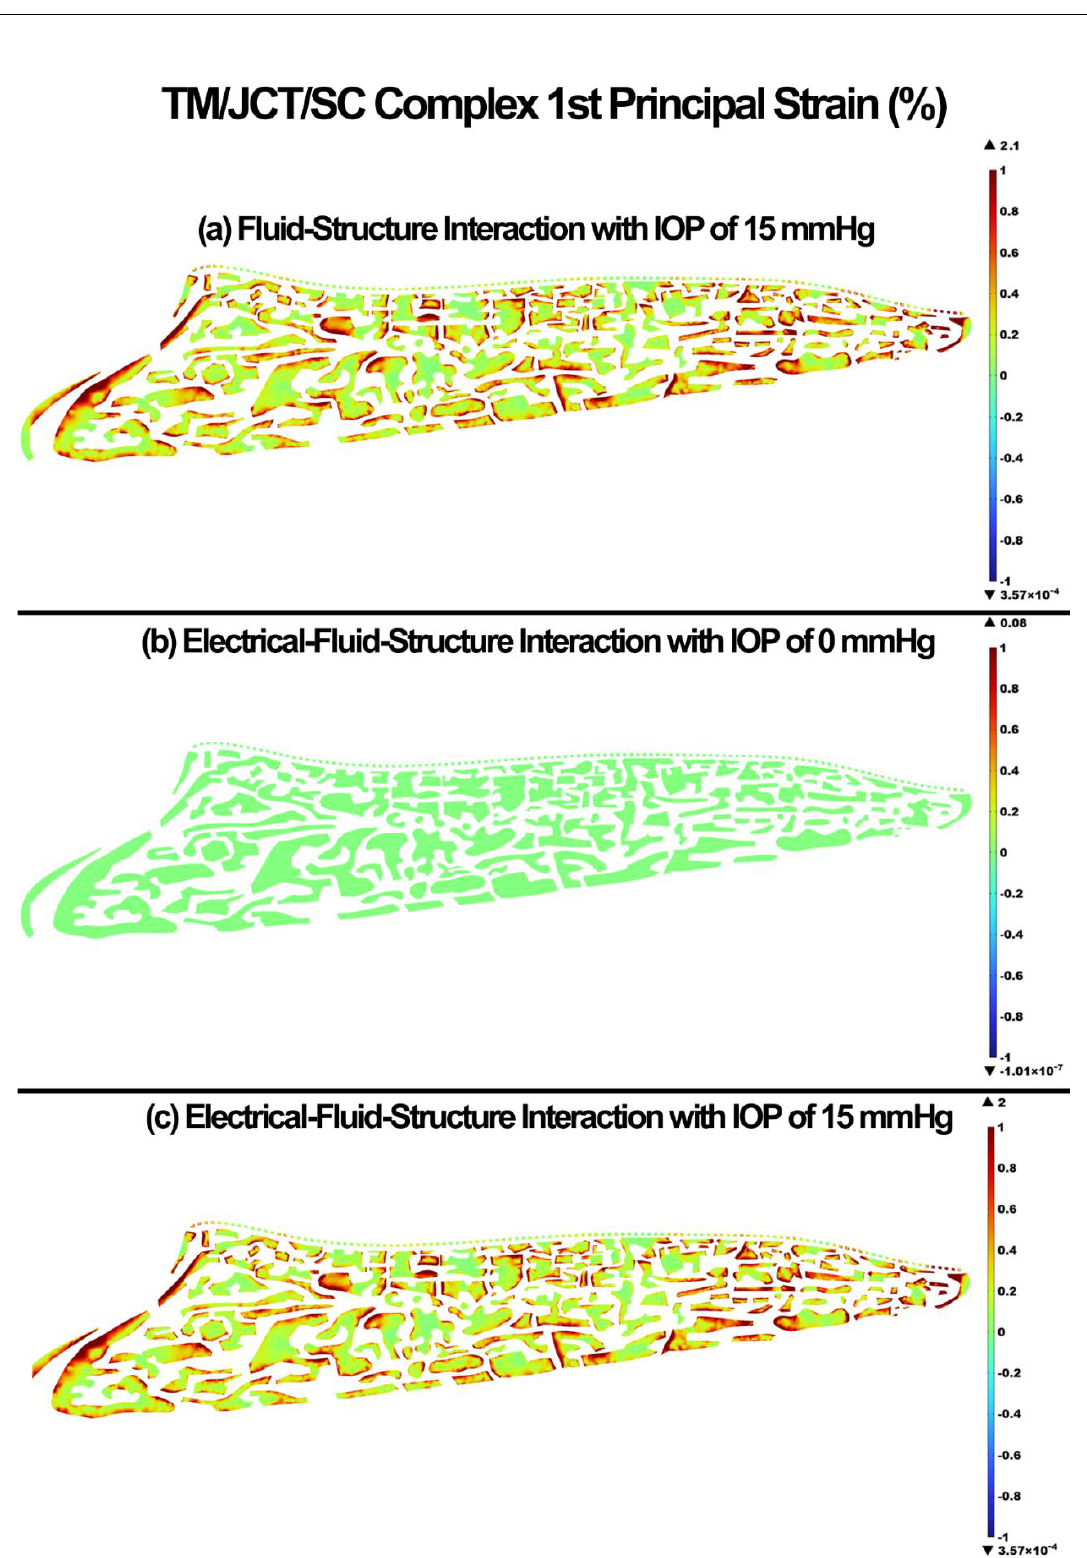
Figure 5. The 1st principal strain in the TM/JCT/SC complex. ( a ) FSI model with IOP of 15 mmHg, ( b ) EFSI with IOP of 0 mmHg, and ( c ) EFSI with IOP of 15 mmHg. The maximum shear stress and strain in the TM/JCT/SC complex for the FSI with IOP of 15 mmHg, EFSI with IOP of 0 mmHg, and EFSI with IOP of 15 mmHg are shown in Figures 6 and 7, respectively. The glycocalyx layer decreased the maximum shear stress and strain in the outflow tissues by 1 × 10 − 4 kPa and 0.2%, respectively.